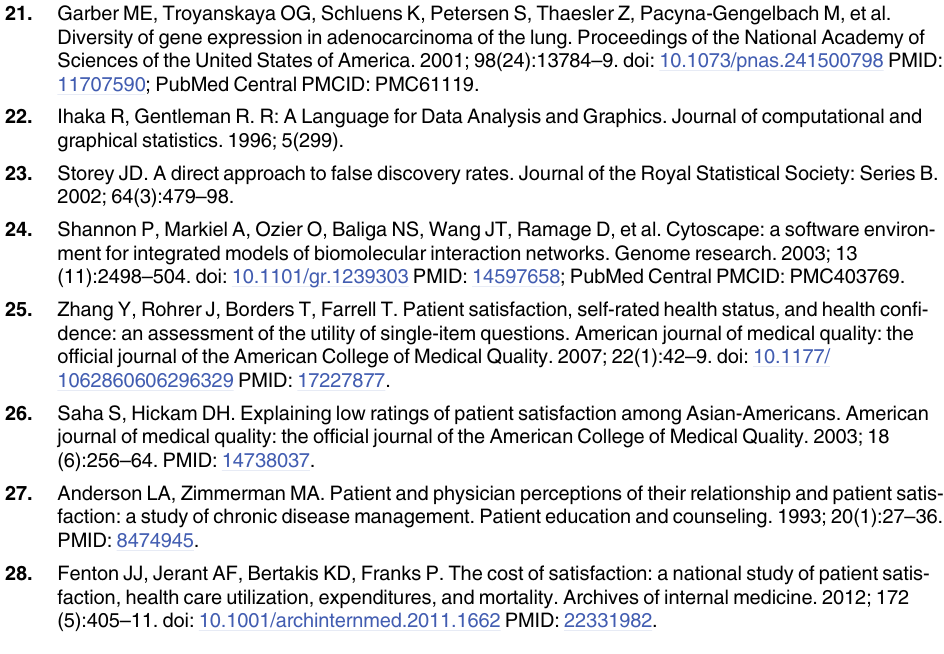
PLOS ONE | DOI:10.1371/journal.pone.0156076 May 26,